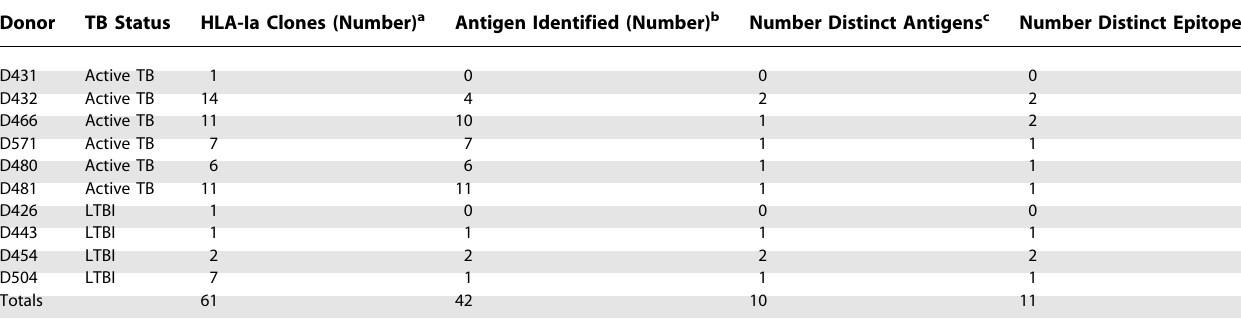
Table 2. Many CD8 þ T Cell Clones Recognize Known CD4 Antigens